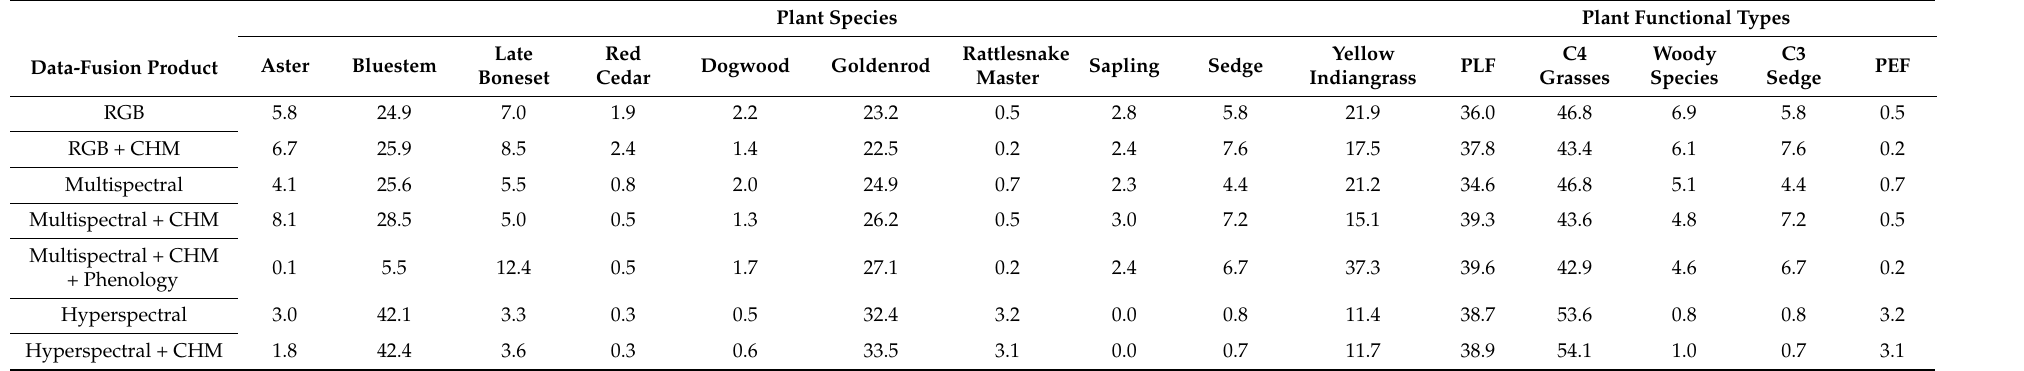
Table 5. Classified percent cover for plant species and functional types for each data-fusion product across our tallgrass prairie study site. Shadows and ground (i.e., class “other” from Figure 6) are excluded. Note: sedges and deciduous saplings were not identified to